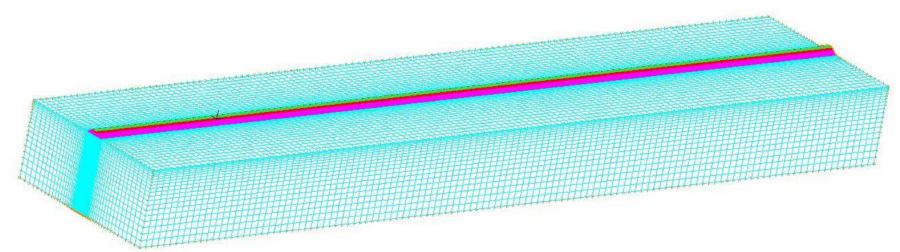
Figure 1. The 3-D FEM for the railway structure.